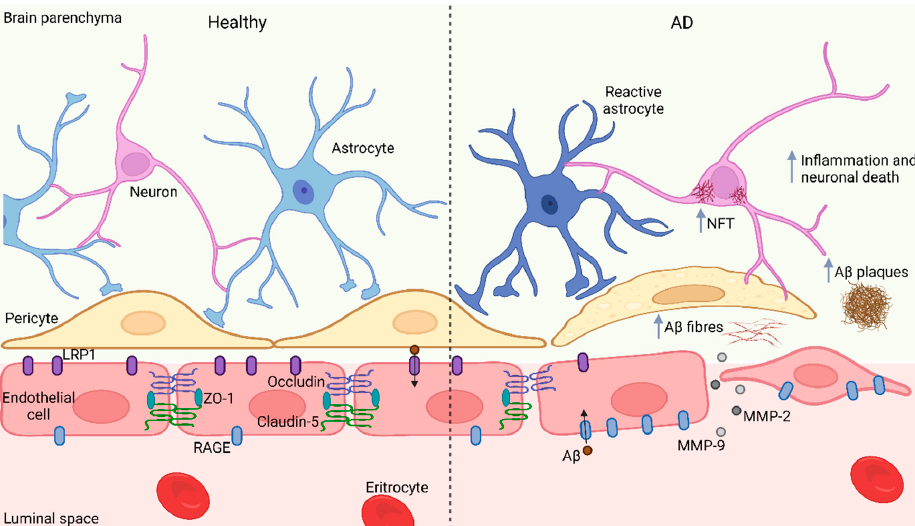
Figure 1. BBB impairment in AD. In normal conditions, levels of RAGE and LRP1 in brain blood vessels are low and high, respectively; however, in AD, blood vessels display opposite levels of these A β clearance proteins leading to A β accumulation and deposition. Moreover, A β decreases the expression of Occluding, Claudin-5 and ZO-1 in brain endothelial cells and increases MMP-2 and MMP-9 activity, thus enhancing BBB permeability. Additionally, A β accumulation induces Tau aggregation, inflammation, and neuronal death. BBB, blood brain barrier; AD, Alzheimer’s disease; RAGE, Receptor for advanced glycation end product; LRP1, Low-density lipoprotein receptor re- lated protein 1; A β , Amyloid β peptide; ZO-1, Zonula occludens; MMP-2, MMP-9, Matrix metallo- proteinase 2 and 9; NFT, Neurofibrillary tangles. Figure created with Biorender. RAGE is the major A β influx receptor that promotes A β deposition; its expression is increased in brain endothelial cells of AD patients [8,102] and the cortex of 5XFAD mice [88,101]. On the other hand, low-density lipoprotein receptor-related protein 1 (LRP1) is the primary mechanism for A β clearance from the brain, and its expression in brain endo- thelial cells is reduced in AD patients and animal models [103]. BBB impairment facilitates the entry of undesired systemic factors with the potential to contribute to AD progression by mainly triggering proinflammatory conditions that eventually promote neurodegeneration [104]. In fact, the abnormal influx of A β oligomers from the milieu to the CNS due to abnormal high and low endothelial levels of RAGE and LPR1 respectively, could contribute to AD progression [79–81]. Nevertheless, it is possible that other biomolecules could display an altered pattern of influx and efflux between the CNS and the periphery. Recent findings indicate that aging impairs the BBB transport of plasma proteins to the brain [84], thus, the entrance of plasma proteins could also be al- tered in AD. Interestingly, BBB endothelial cells display the highest number of AD-related genes with altered expression, which strongly suggests that their altered function could play a key role in AD pathogenesis [105]. Hence, harmful systemic factors could reach the brain and contribute to AD manifestation due to a compromised barrier function of brain endothelial cells. Harmful circulating factors that could exacerbate neurodegeneration increase with age. Proteomic analyses revealed that aged blood carries the chemokine CCL11, which is capable of impairing neurogenesis and cognitive performance when administered to young mice; remarkably, antibody blockade of CCL11 rescued the impaired neurogenesis of mice and it would be worth testing whether this strategy is also able to rescue cognitive